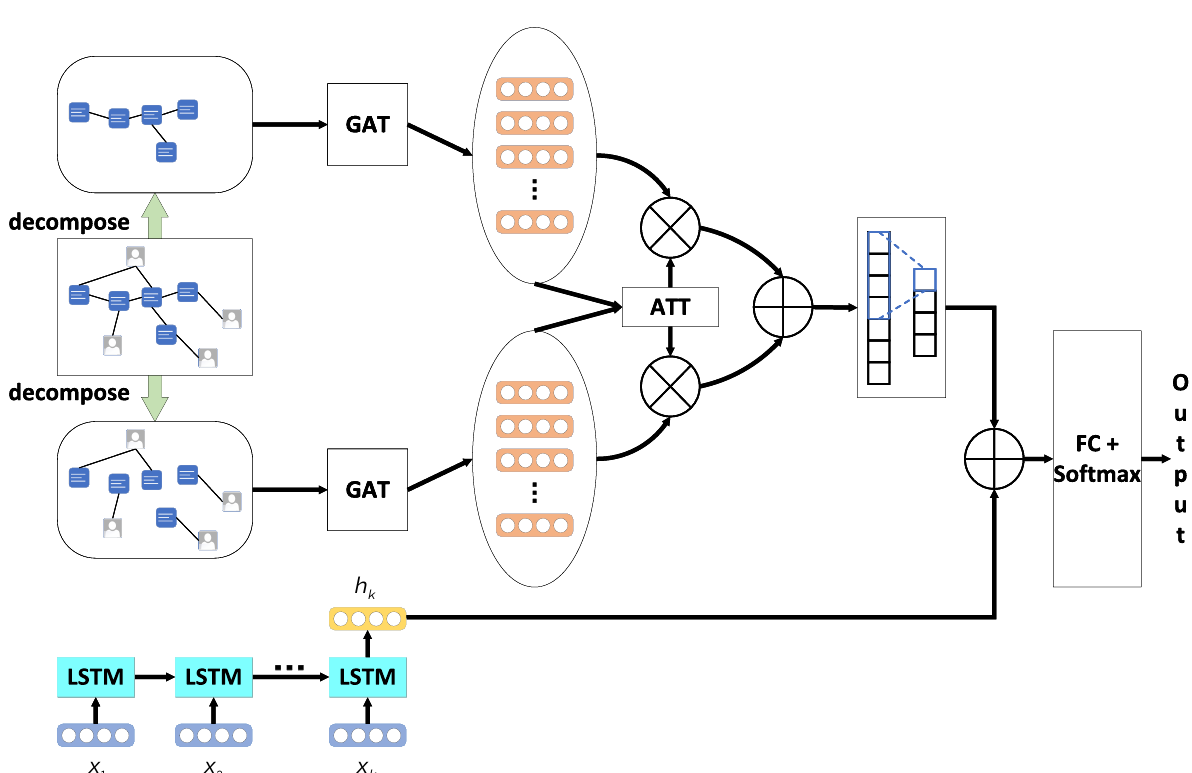
Figure 3. Overall structure of our proposed